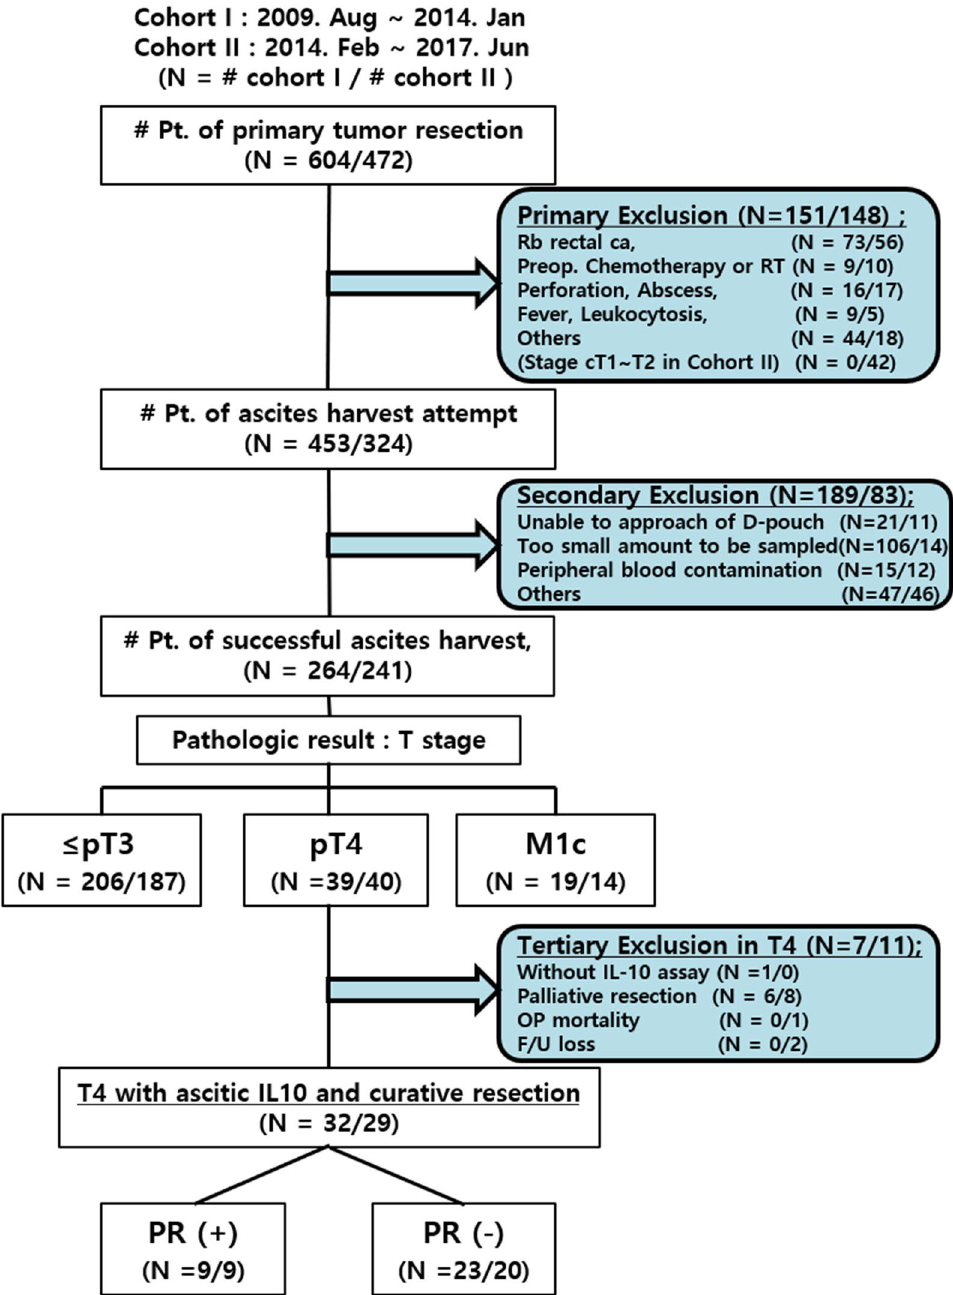
Figure 1. Patient enrolment and exclusion criteria for ascites sampling and assessment of peritoneal recurrence. To investigate the relationship between peritoneal tumor burden and peritoneal immune characteristics, ascites was collected from patients undergoing surgery for colorectal adenocarcinoma since August 1, 2009. Patients with the following peritoneal conditions that could have influenced the results were excluded: patients with extraperitoneal rectal cancer (Rb rectal cancer) determined by pelvic MRI and operative findings (the lower margin located below the anterior peritoneal reflection); those who had undergone preoperative chemotherapy or radiotherapy; and those with intestinal perforation, abscess, leukocytosis, or fever (over 37.3 °C, two or more consecutive times at 4-h intervals within 24 h). Patients who did not agree to take part in the study were also excluded (primary exclusion). By January 31, 2014 (cohort I), we collected ascites from a sufficient number of patients to identify trends in cytokine distribution in three groups of patients: ≤ pT3, pT4, and M1c. Therefore, we did not attempt ascites sampling from patients with probable T1 or T2 (clinical stage T1 or T2) stage tumors from February 1, 2014 (cohort II), as it was unnecessary to have ascites samples from so many patients with ≤ pT3, while patients with clinical T3 tumors were not excluded because it was possible that those tumors would be classified as T4 on pathological examination. Ascites harvest was attempted in all other patients who were not subject to primary exclusion; however, there were some failures of ascites sampling due to adhesions, insufficient ascites, or blood contamination of ascites, and these patients were also excluded (secondary exclusion). Furthermore, patients undergoing palliative resection (R1 or R2 resection), those with operative mortality (who died within 30 postoperative days), and those for whom no postoperative surveillance imaging was conducted (follow-up loss) were not surveyed for peritoneal recurrence (tertiary exclusion in the pT4